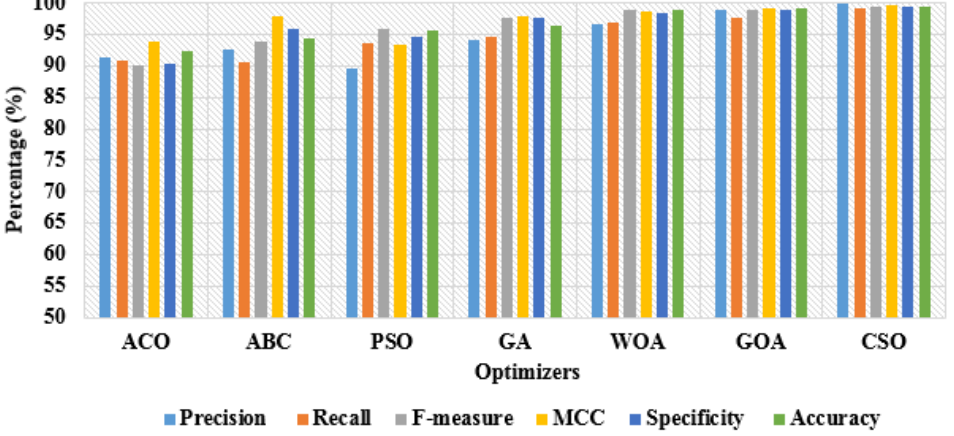
Figure 10. Graphical comparison of dissimilar optimizers with 80% training and 20% testing of data.